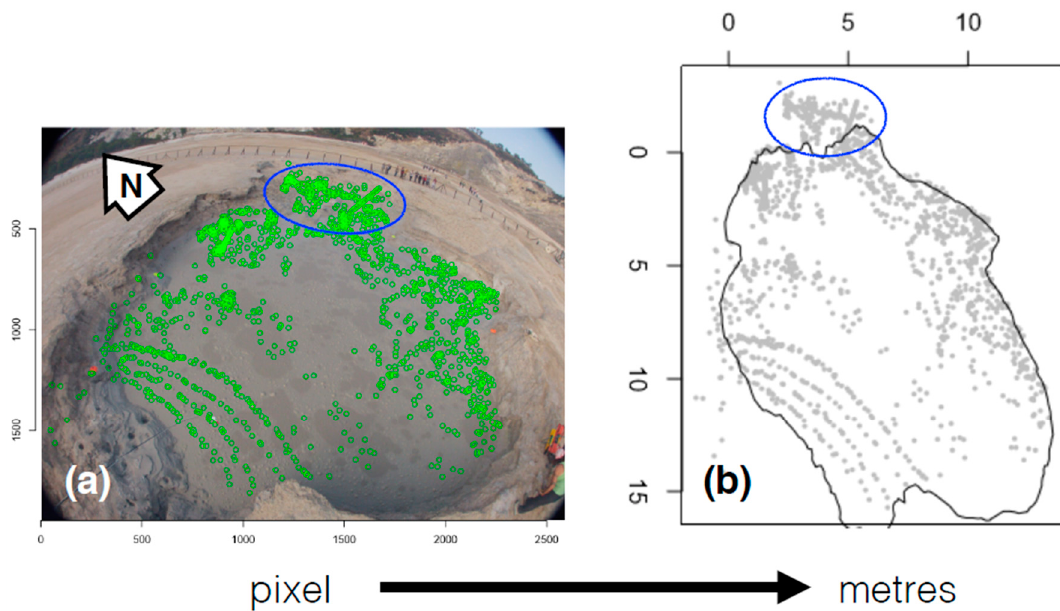
Figure 4. Graphical procedure (MTrackJ and ImageJ software) to mathematically transform pixels ( a ) in the picture into meters ( b ), based on the distances between the fluorescent cones measured in the field. The green ( a ) and grey ( b ) dots are the MultiGAS measurement points. The blue-circle marks the area included in diffuse CO 2 flux measurements, the subaerial degassing area in June 2017 (see Figure 7).